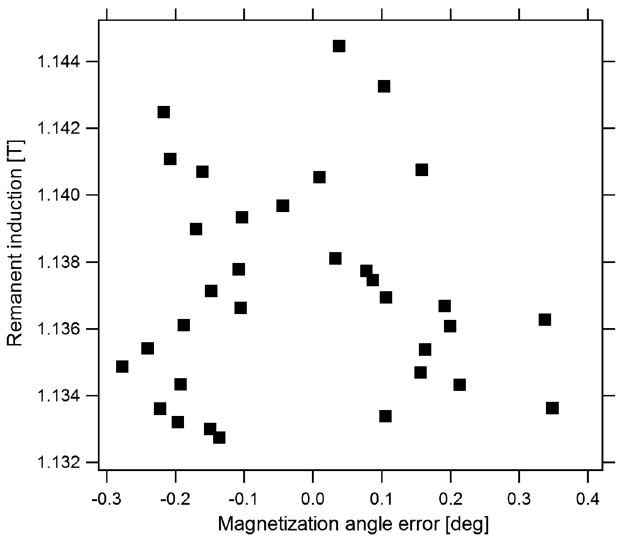
FIG. 10. Characteristics of the 36 NdFeB PMs used in the prototype. The average remanent field is BR ¼ 1 . 137 T. These PM are recycled from an old